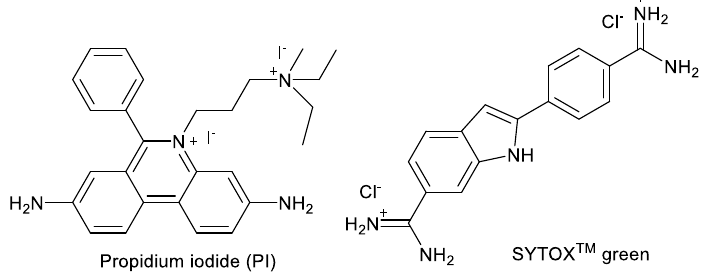
Figure 2. Structures of SYTOX TM green and propidium iodide (PI).